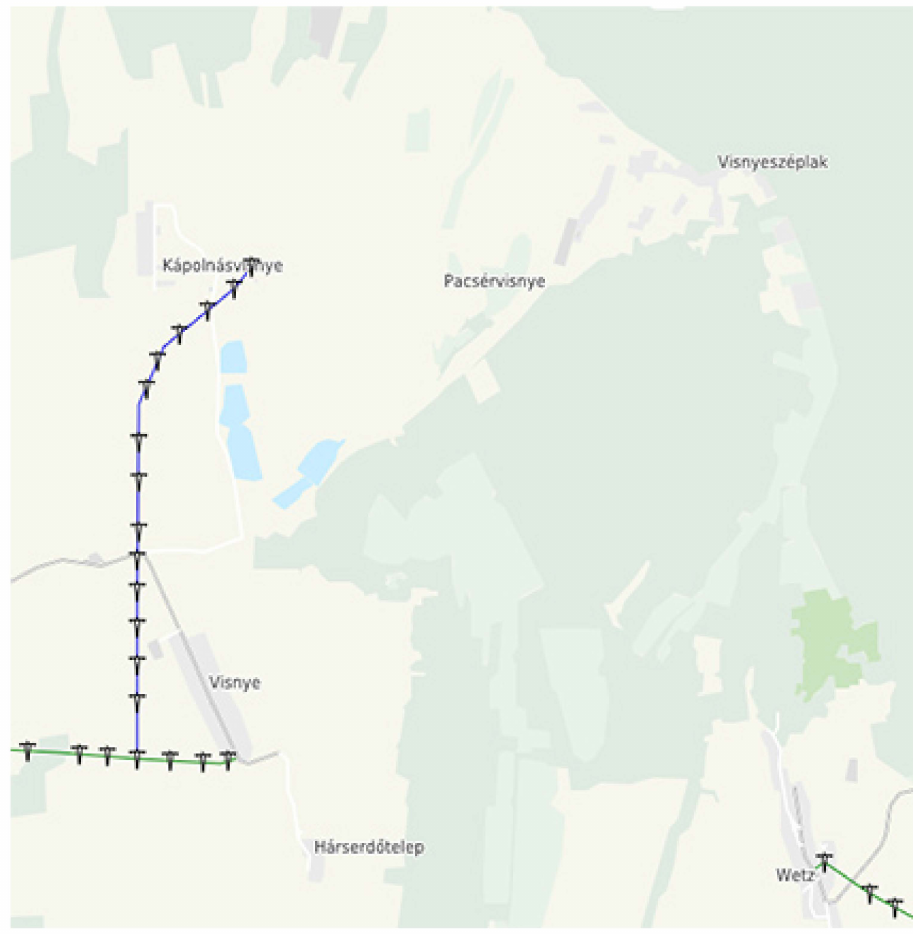
Figure 5. Medium-voltage network around Visnyesz é plak